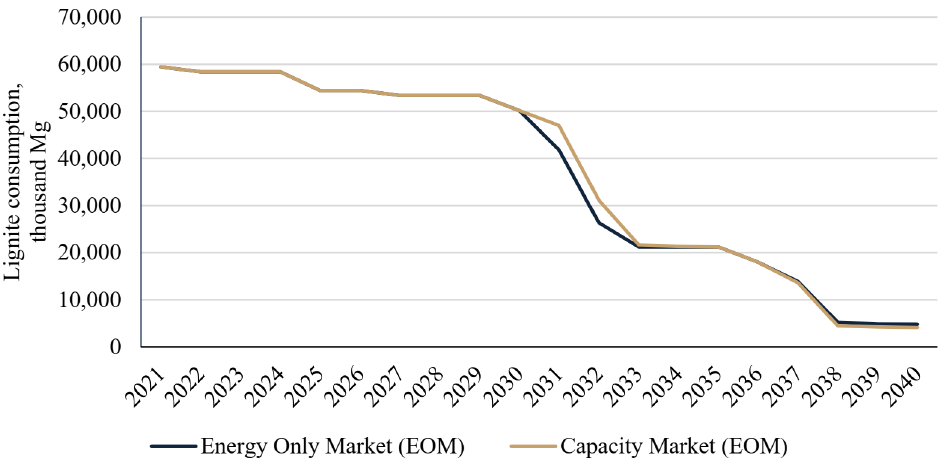
Figure 17. Lignite consumption for electricity generation under the EOM and CM scenarios in 2021–2040.